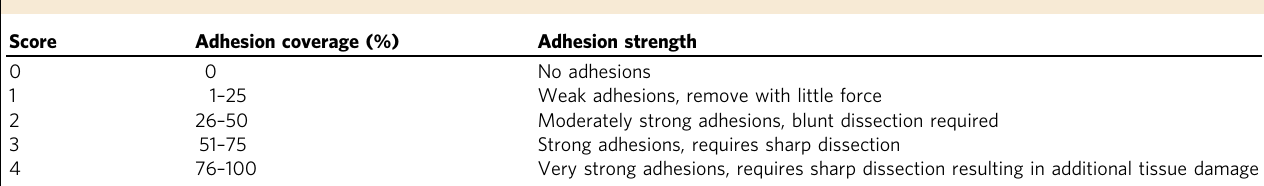
Table 3 Pilot porcine adhesion scoring